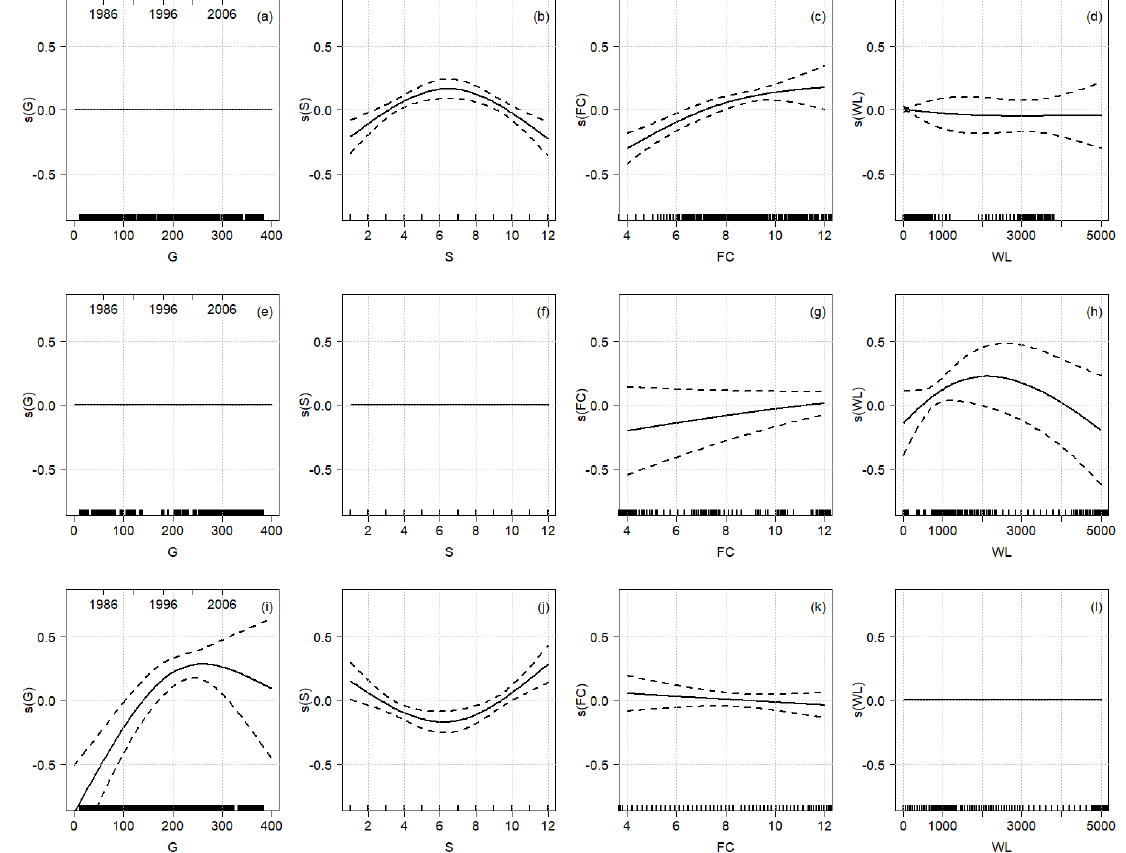
Figure 7. Smooth terms (continuous black lines) and standard error bounds (dashed lines) of S4 model ( TRR = s ( G ) + s ( S ) + s ( FC ) + s ( WL ) ) for C1 ( a – c ), C2 ( e – g ) and C3 ( i – k )